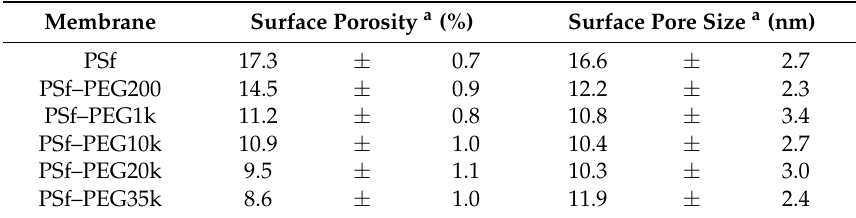
Table 2. Physical characteristics of PSf supports prepared using PEG of varying molecular weights. Membrane